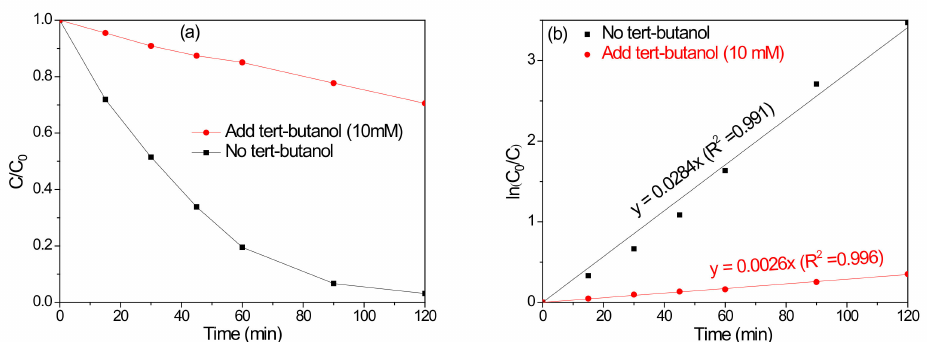
Figure 6. Effect of tert-butanol on catalytic degradation of OG with H 2 O 2 over F-Fe 3 O 4 -1. ( a ) C/C s - time plots and ( b ) ln(C 0 /C)-time plots. Reaction conditions: OG (0.1 mM, pH 6.5), H 2 O 2 (40 mM), and F-Fe 3 O 4 -1 (0.5 g/L) at 40 ◦ C.